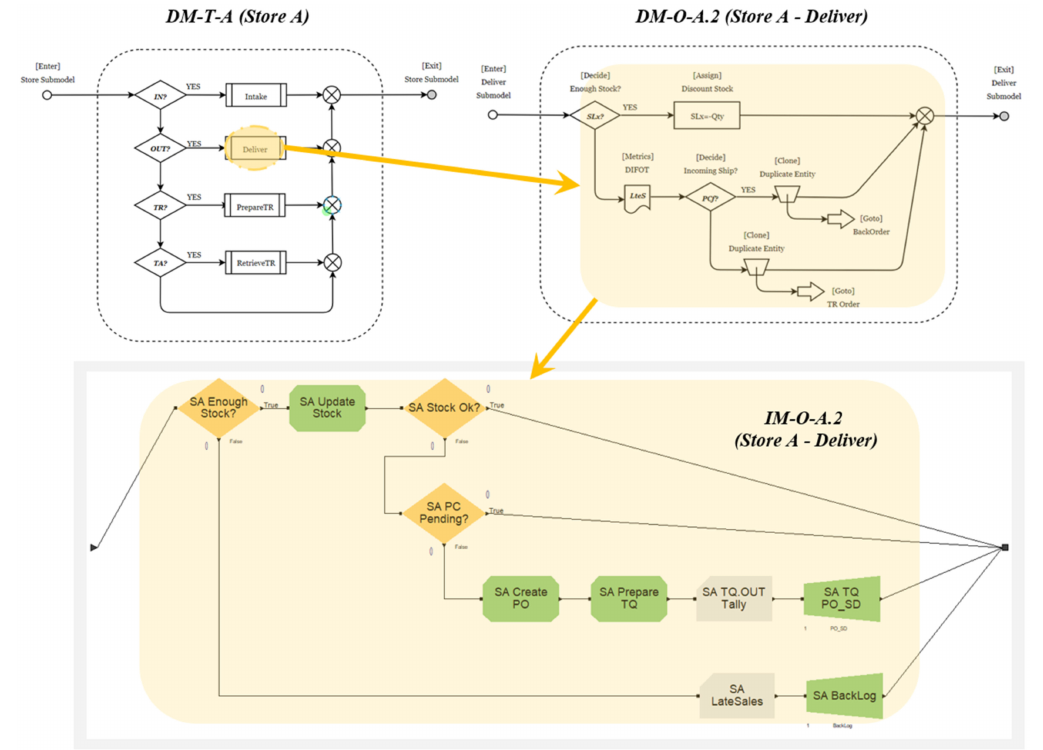
Figure 26. Conversion of DM-0-A.2 into IM-0-A.2 highlighted in beige. Top left is DM-T-A (de- tailed in Figure 21) and top right is DM-O-A.2 (detailed in Figure 22). The diagram shows the relationship between the sub-models. The details of the individual models are not relevant to the present discussion.